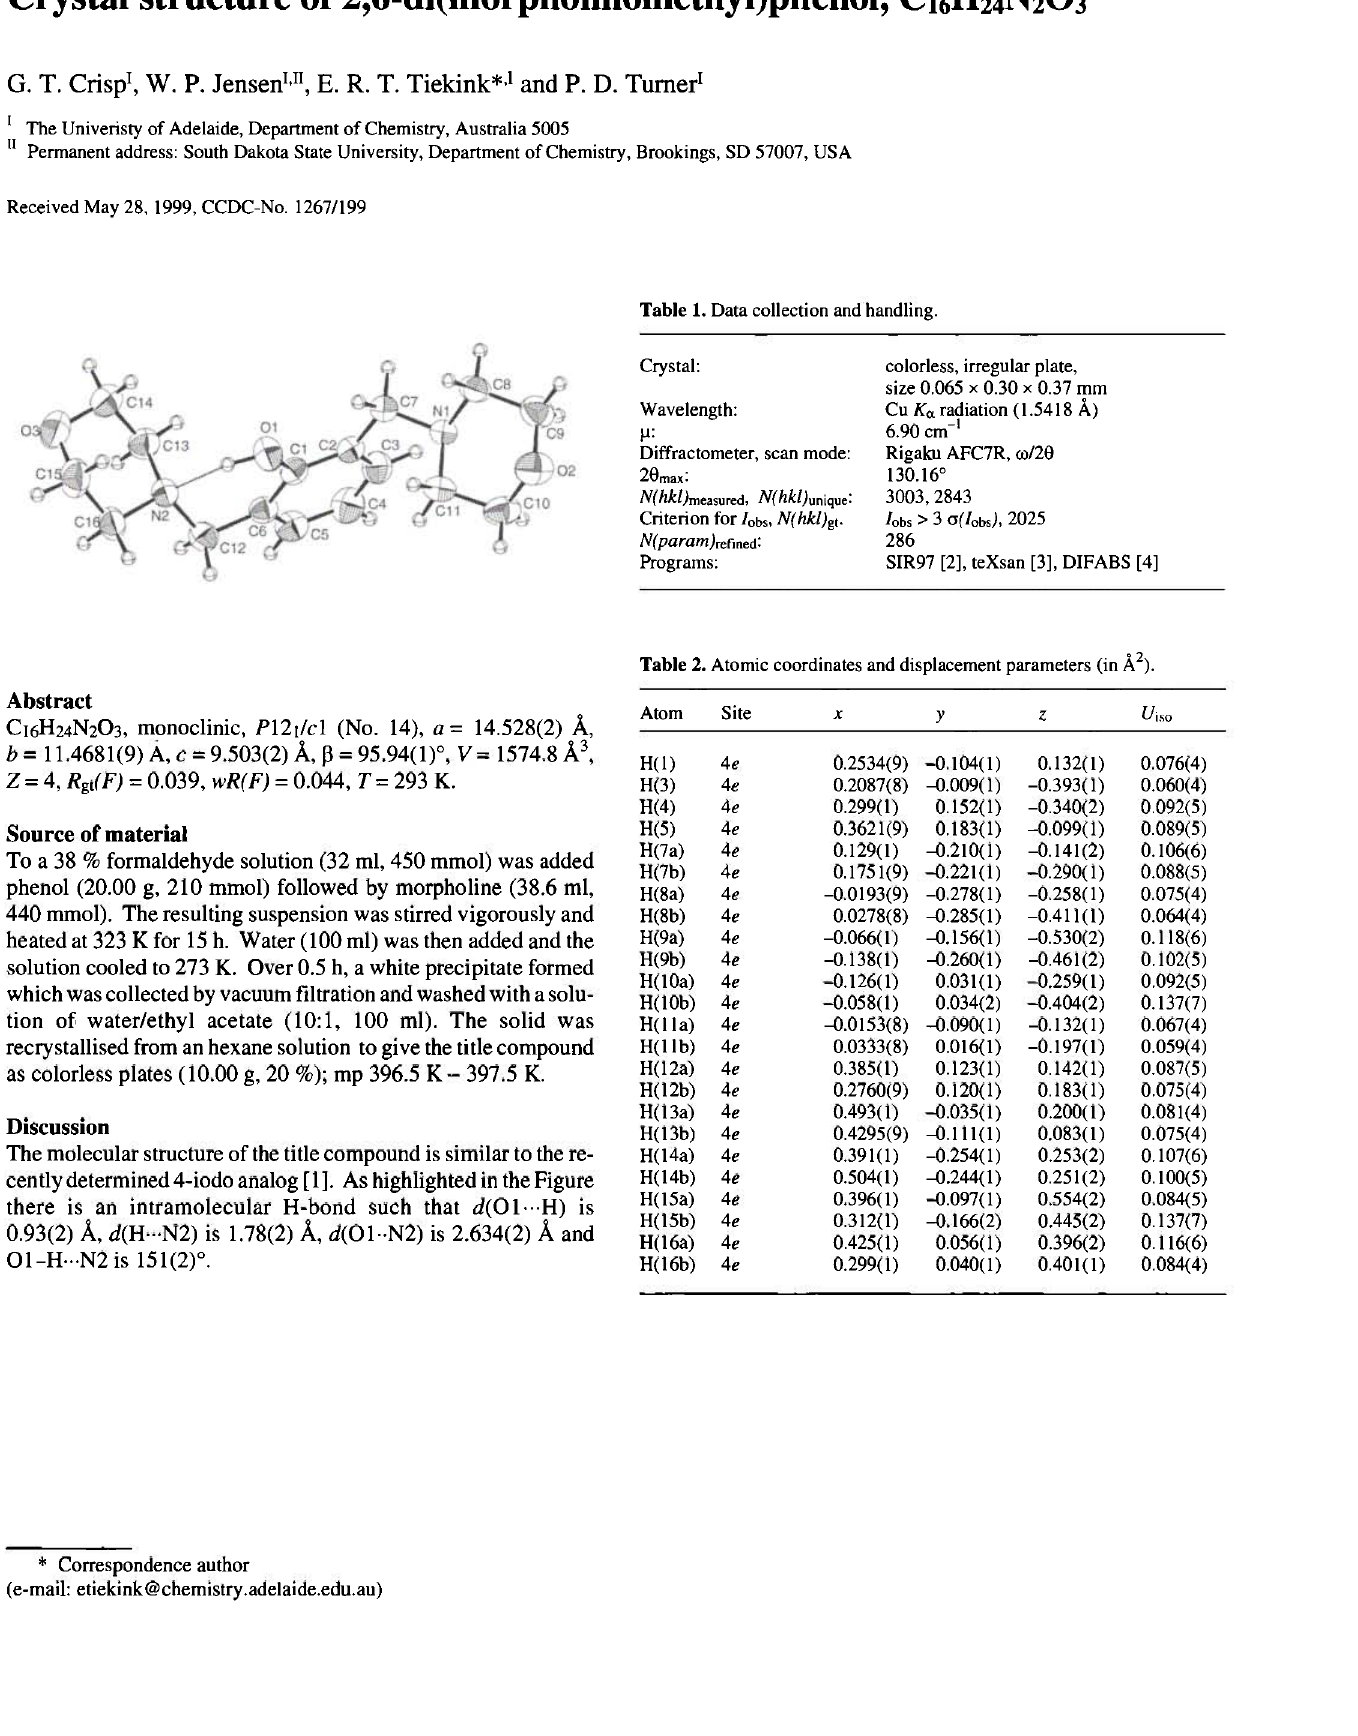
Table 1. Data collection and handling.